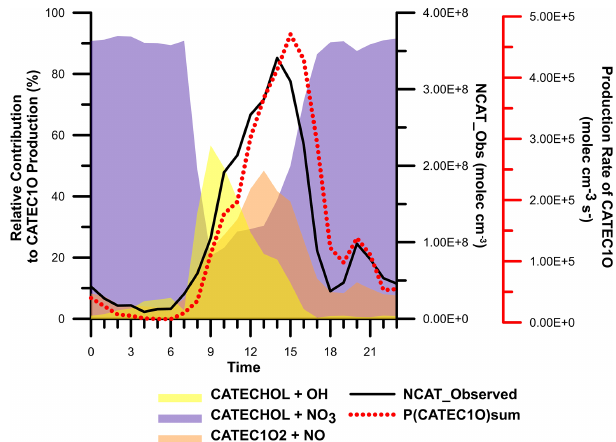
Figure 9. Diurnal variation in the relative contribution of the hy- droxyphenoxy (CATEC1O) pathway to overall nitrocatechol forma- tion. Also shown are the observed concentrations of nitrocatechol and the summed rates of CATEC1O